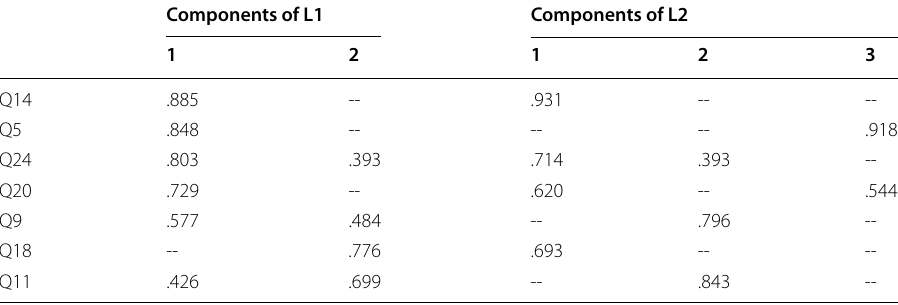
Table 13 Rotated Component Matrix for L1 and L2 Use in Oral Performance